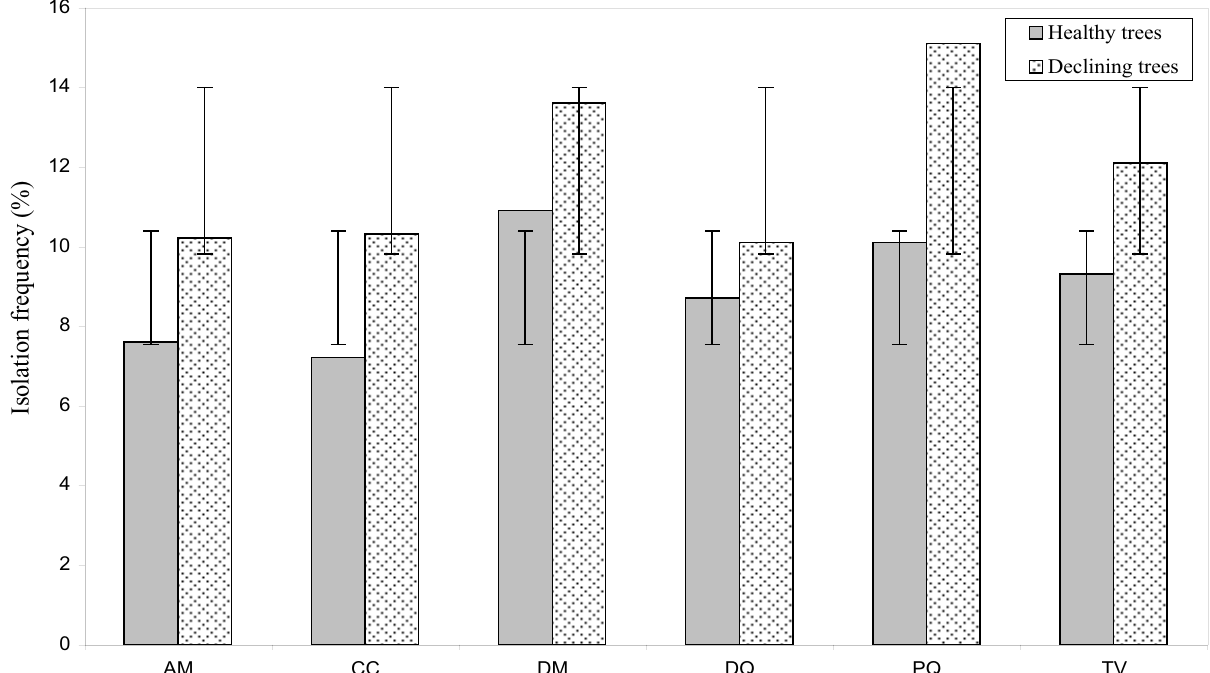
Fig. 1. Isolation frequency (%) of fungal species identified on healthy and declining trees (sum of all samples). The bars indicate the standard deviation. AM = Acremonium mucronatum ; CC = Cladosporium cladosporioides ; DM = Diplodia mutila ; DQ = Discula quercina ; PQ = Phomopsis quercina ; TV = Trichoderma viride .